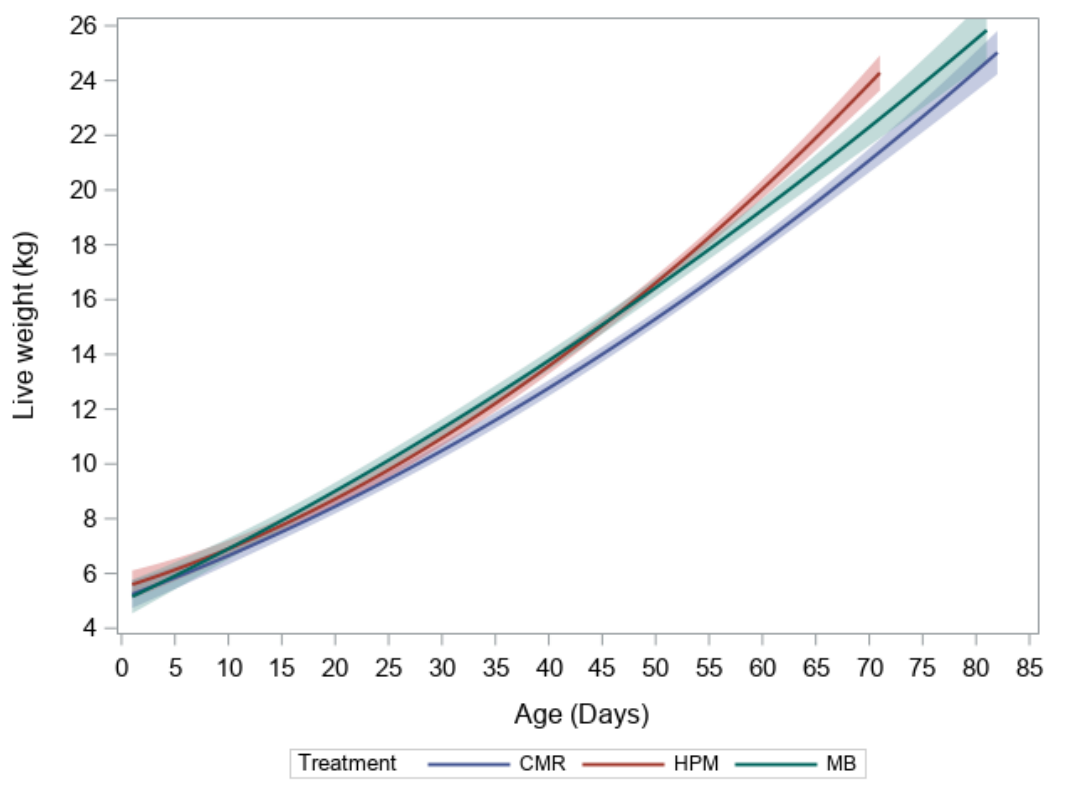
Figure 1. Second order polynomial with 95% confidence interval for live weight and age of lambs fed commercial milk replacer (blue), high protein milk (red), milk blend (green) diets and slaughtered at 22 kg live weight.